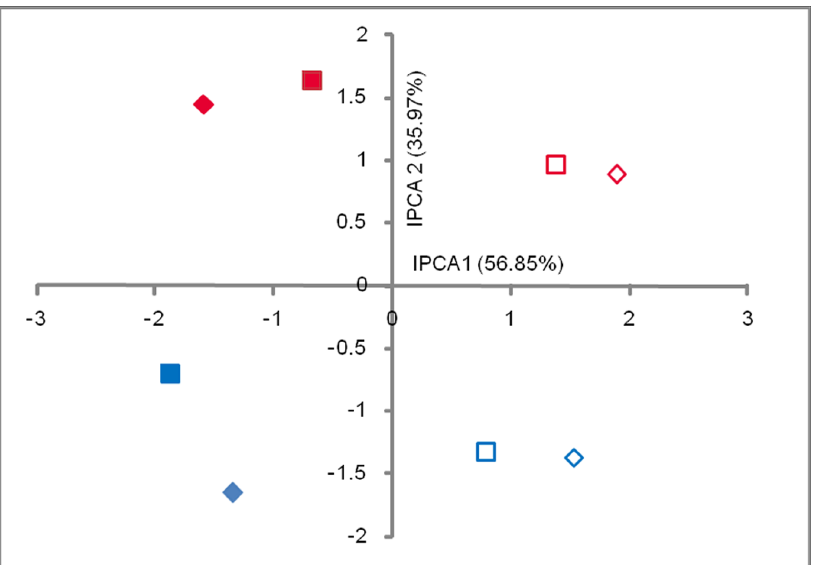
represent plants with natural pathogen pressure of Rhizoctonia solani in the field and closed data points at additional pathogen inoculation of R. solani AG1-IB. Red: Sampling after 2 weeks of growth; Blue: Sampling after 5 weeks of growth.